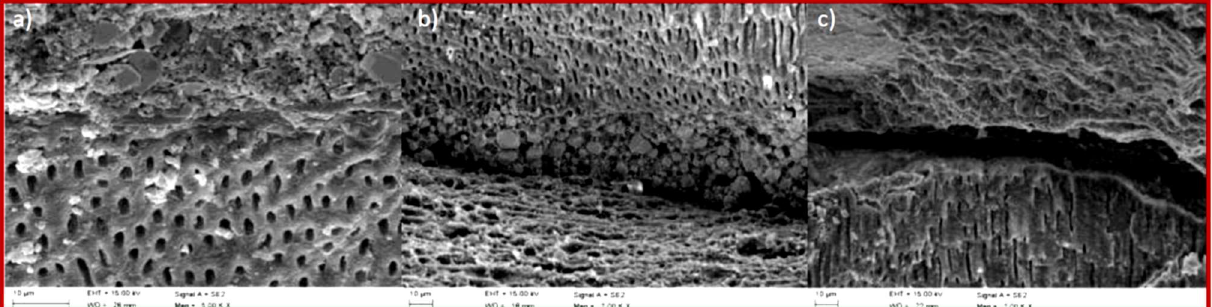
Figure 16. Scanning electron microscope view of the tooth fracture after filling the root canal by cold lateral condensation: ( a ) tight connection of the filling material based on Resilon-type polymer materials with the dentine of the root canal, showing fine particles of sealant (2000×); ( b ) border of the connection of the three layers of root canal dentin, sealant, and filling material based on gutta-percha; leakage in two places at the border of the joint between the sealant and the filling material (2000×); ( c ) leakage on the border of the sealant and the dentine of the root canal, with the method of filling and obturation as ( b ) (2000×).